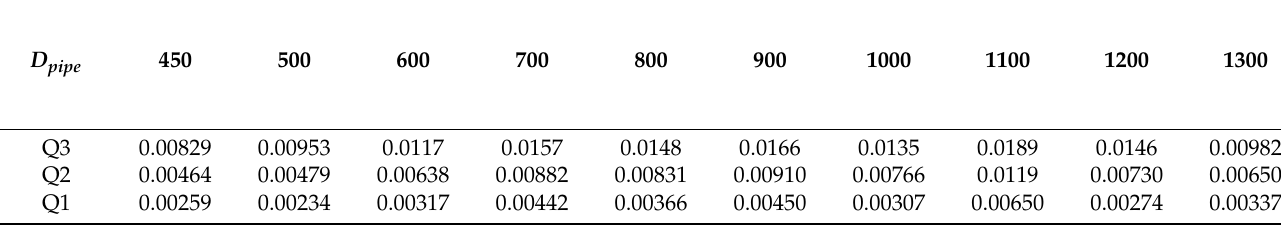
Table 1. Quartile of λ i in accordance with sewer pipe diameter.